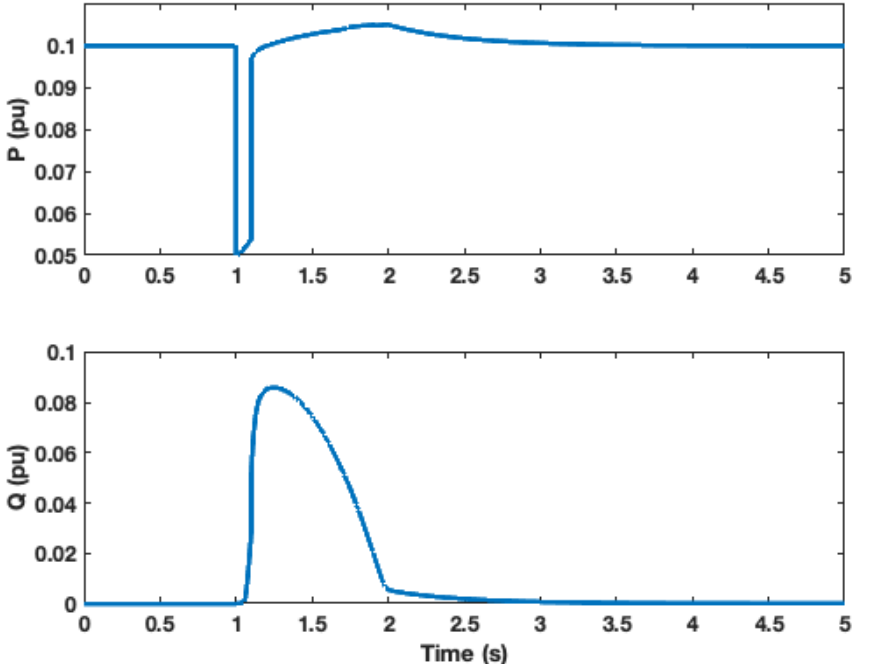
Figure 5. Aggregated real and reactive power of PVs obtained from OpenDSS.